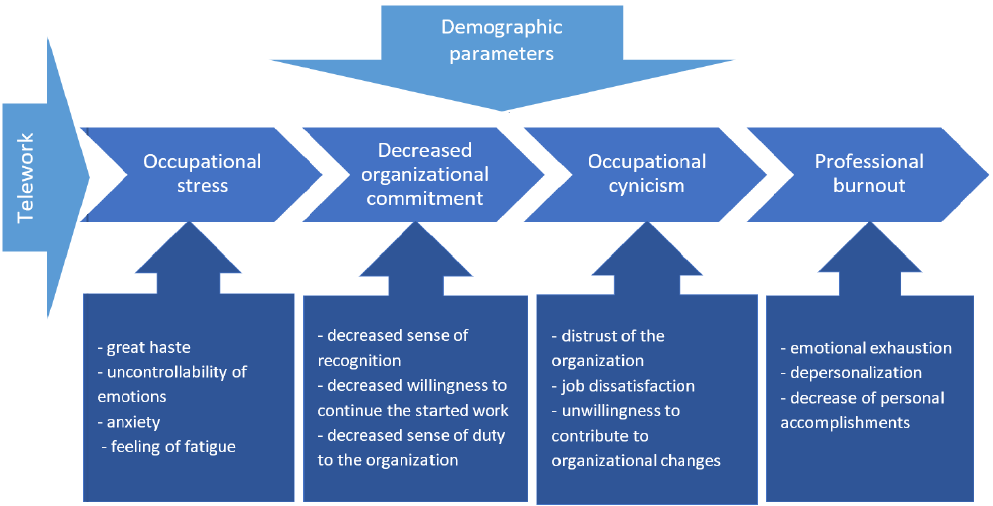
Figure 1. The model of employee occupational stress-induced impact to work commitment, cynicism, and professional burnout. Compiled by the authors.